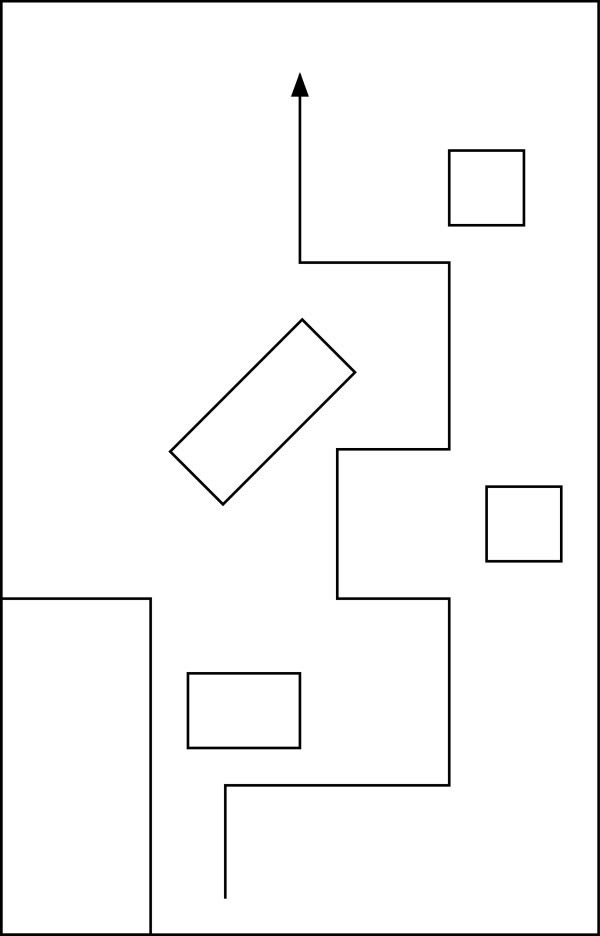
Obstacle Course 1.